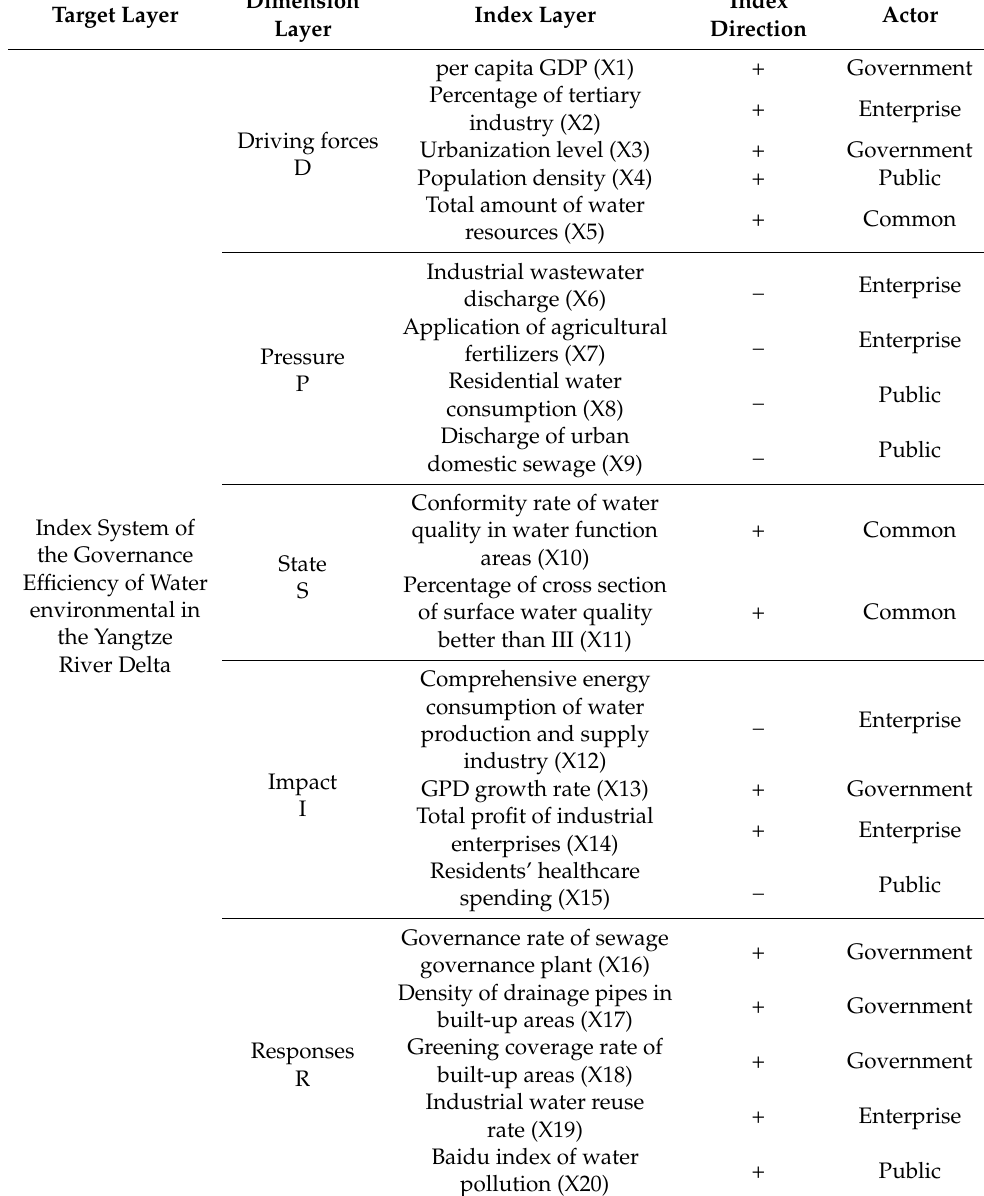
Table 1. Index system of the governance efficiency of water environmental in the Yangtze River